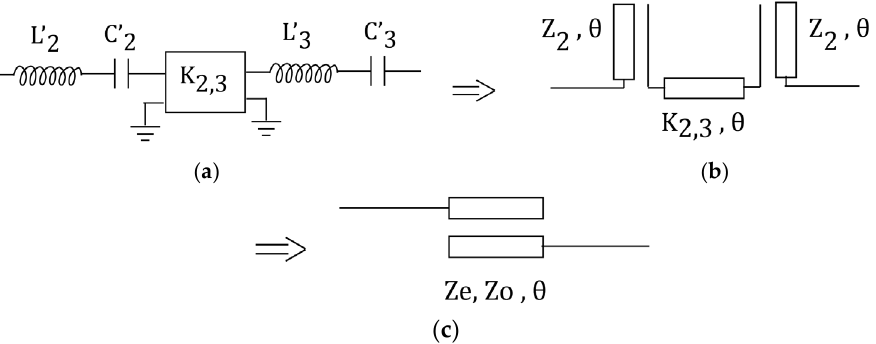
Figure 5. Coupled line transformation. ( a ) Inductances and capacitances with impedance inverter. ( b ) Transmission line with two serial open-circuited stubs. ( c ) A coupled transmission line. This is done by applying Richards’ transformation with (8) and (9). Then, to symme- trize the coupled lines, we consider Z 2 = Z 3 .